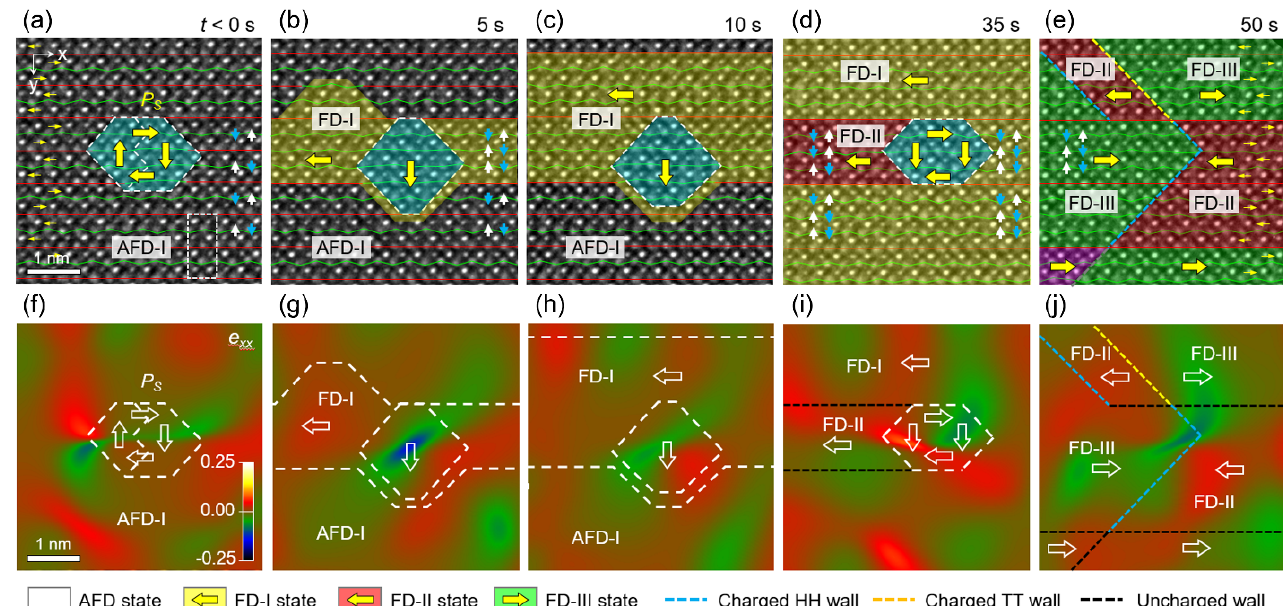
Figure 7. Structural phase transitions of PbZrO 3 induced by electron-beam irradiation in a TEM. ( a,b ) Changes in lattice parameter ( √ 2 a p , √ 2 b p ) and volume ( V = √ 2 a p × √ 2 b p × c p ) plotted as a function of irradiation time, respectively. ( c–e ) Atomic-resolution NCSI-TEM images of an AFD-FD phase boundary and associated structural phase transitions recorded along [001] O direction, respectively. The oxygen displacements in ( c ) are indexed by (+, 0, –) symbols and colorful solid lines. The yellow arrows denote antiparallel Pb displacements. The atom types are Pb—yellow, Zr—green, O—red circles, respectively. ( f ) 2D cycloidal order of polarization for the transient FE-FD phase obtained using quantitative TEM study [127].